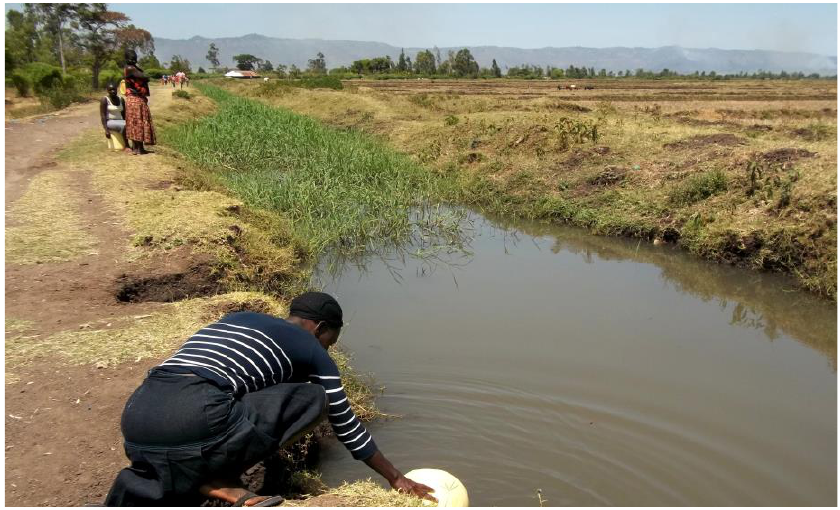
Figure 4. Woman fetching water from irrigation canal for domestic use